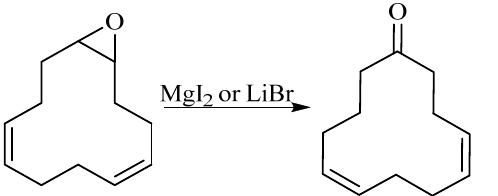
Figure 1. 1,2-Epoxy-5,9-cyclododecadiene (ECDD) isomerization to 4,8-cyclododecadienone.